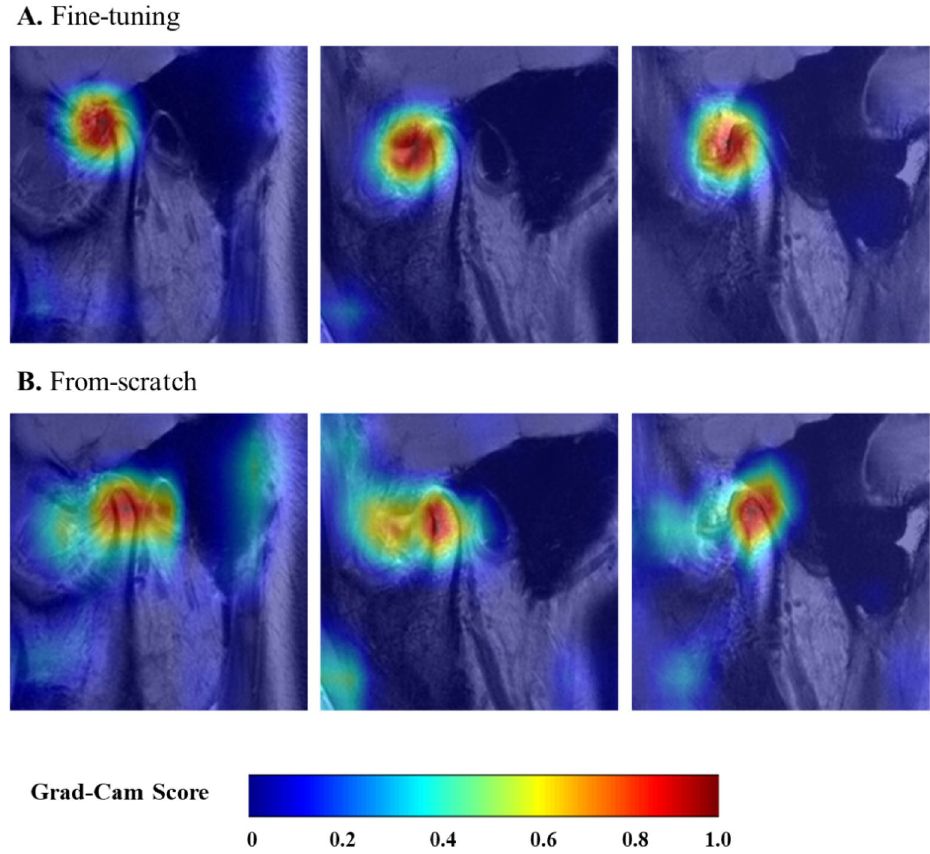
Figure 5. Grad-CAM visualizations of the fine-tuning ( A ) and from-scratch ( B ) models. The same sample images are displayed column-wise. The images from the fine-tuning model are more focused on the regions of interest (ROIs).